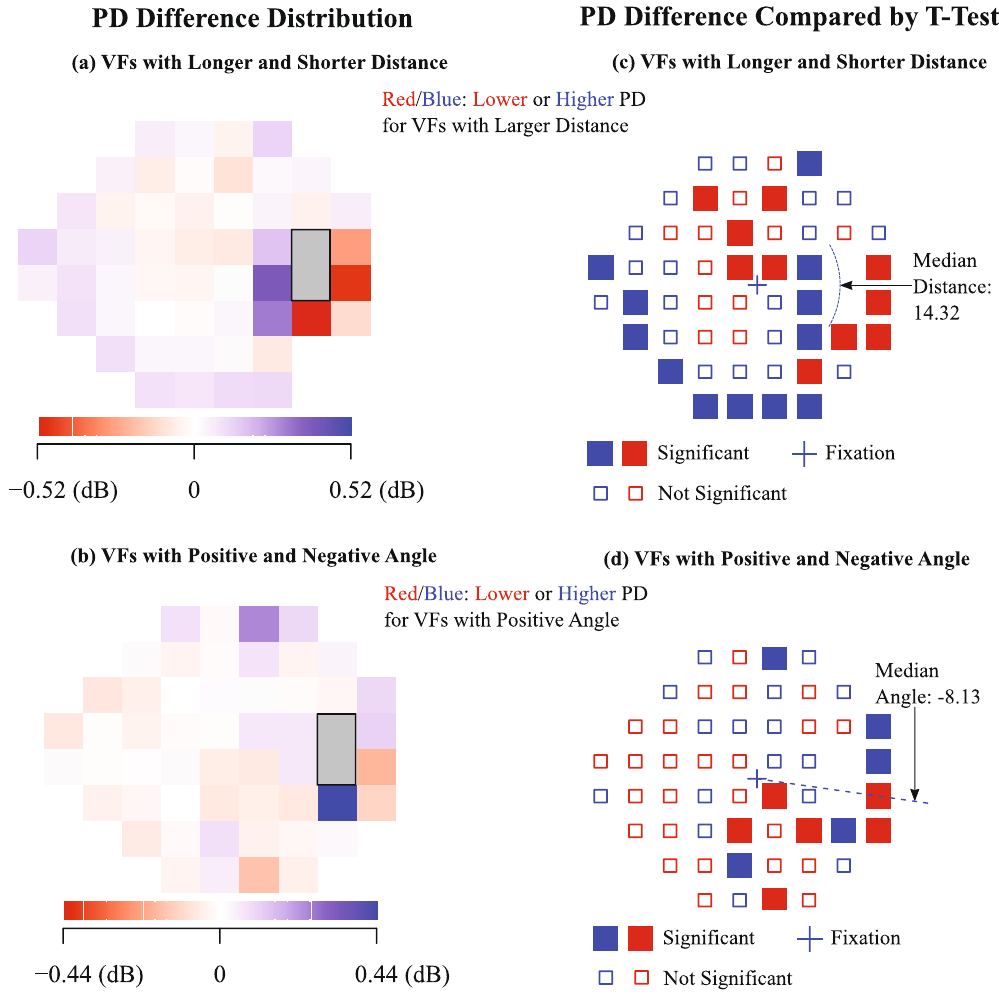
Figure 4. PD value difference effects with respect to NBSL relative to fixation. PD difference compared by t-test ( a ) and spatial distribution ( b ) between the group with NBSL distances longer or equal than the median of all NBSL distances and the group with NBSL distances shorter than the median of all NBSL distances. PD difference compared by t-test ( c ) and spatial distribution ( d ) between the group with NBSL angles larger or equal than the median of all NBSL angles and the group with NBSL angles smaller than the median of all NBSL angles. P-values less than 0.05 after multiple comparison correction with false discovery rate were considered as